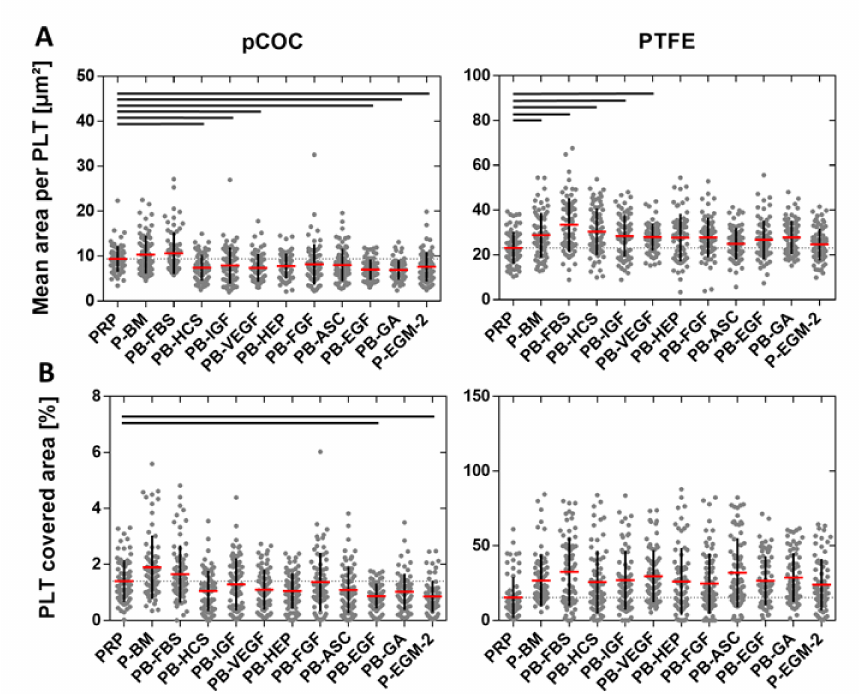
Figure 3. Quantification of platelet adherence to plasma-treated cyclic olefin copolymer (pCOC) and poly(tetrafluoro ethylene) (PTFE) assessed as mean area per platelet (PLT) and PLT covered area. Platelet-rich plasma (PRP) was incubated under static conditions for 1 h at 37 ◦ C with basal medium (BM) or with BM containing one of nine different supplements or with BM containing all nine supplements (see Table 1 for nomenclature) in a ratio of 1:1 resulting in a concentration of 50,000 PLT µ L − 1 . PRP served as control. Images of phalloidin-stained PLT were quantitatively analyzed by ImageJ software to obtain the mean area per PLT ( A ) and the PLT covered area ( B ). Thin dashed line shows the value for PRP (control). Data represent the arithmetic mean (red) ± standard deviation (black), n = 72 per supplement. Black lines indicate significant differences with p ≤ 0.0493. The PLT covered area is another parameter for the assessment of